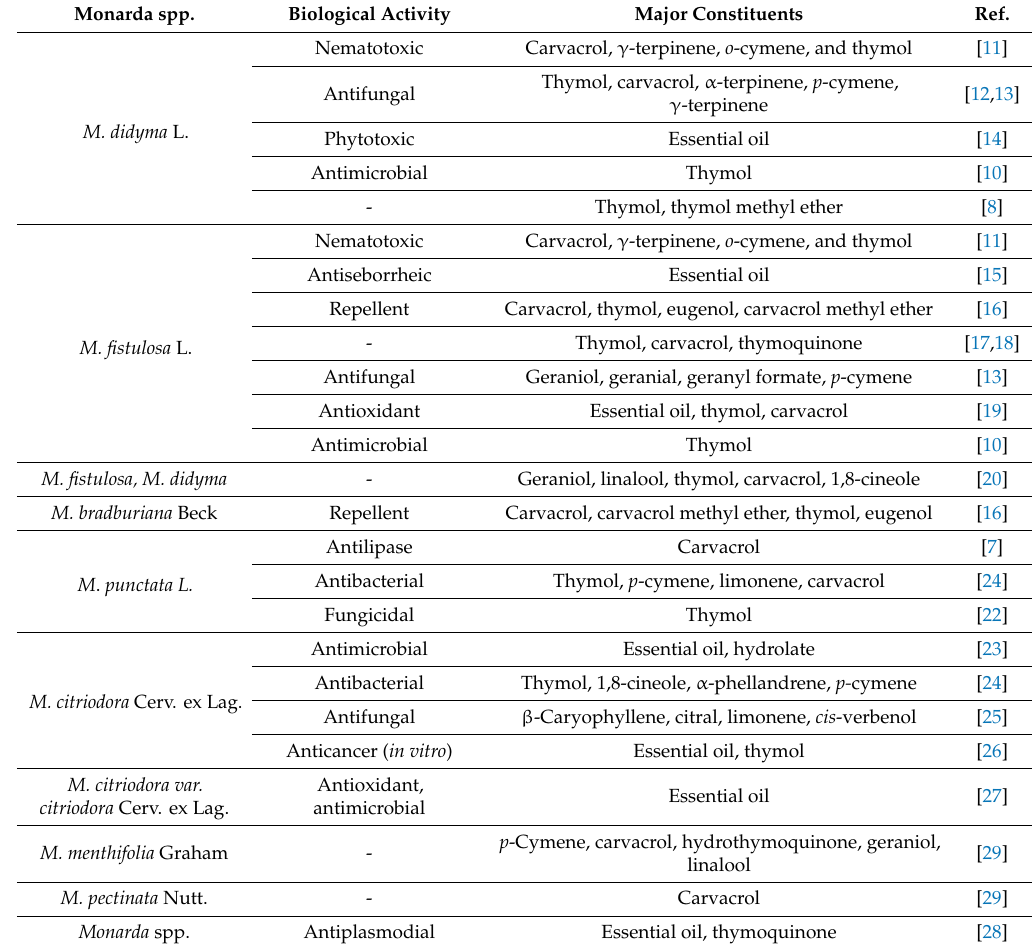
Table 1. Biological activity of essential oils of Monarda species and their major constituents (literature survey). Monarda